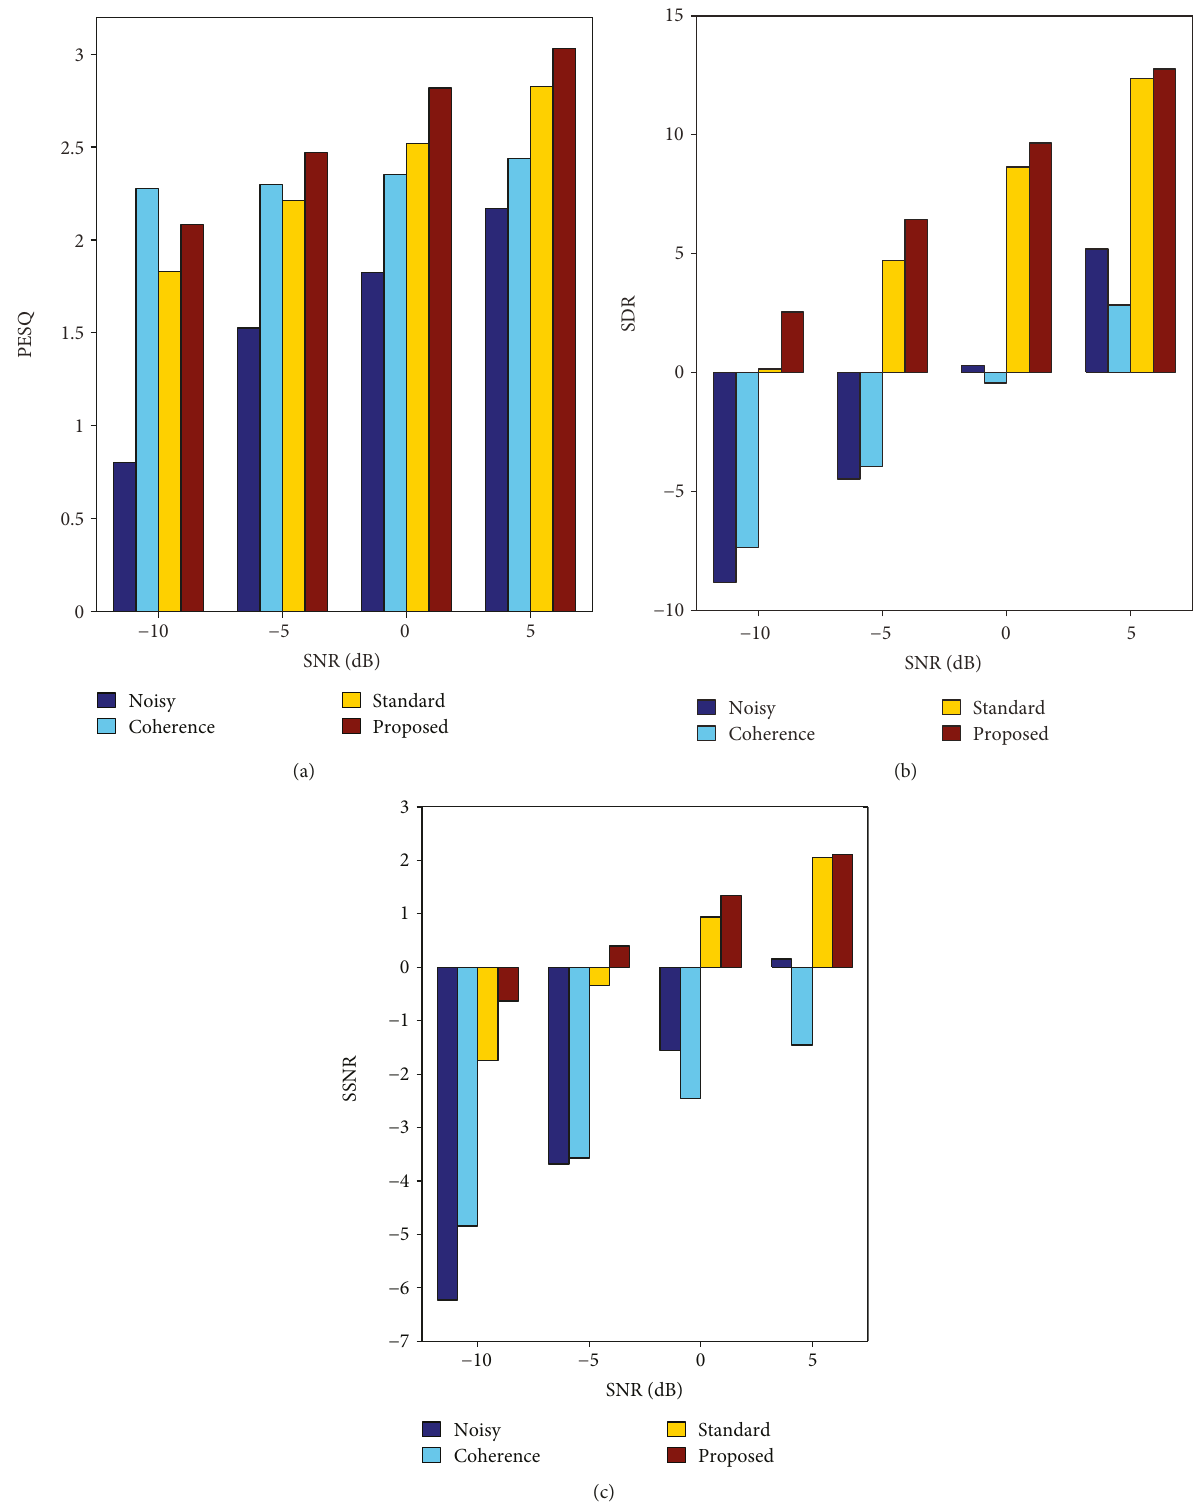
Figure 3: PESQ, SDR, and SSNR scores in Factory1 noise